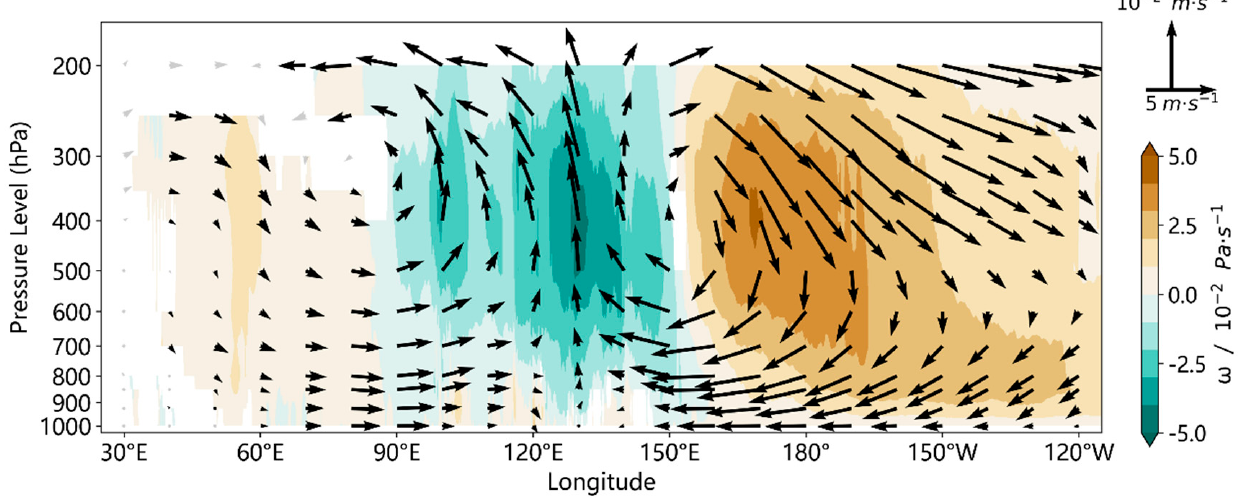
Figure 9. Vertical section differences (strong years minus weak years) of equatorial (average of 5 ◦ S–5 ◦ N) vertical velocity (shade) and latitudinal circulation (arrow) over the tropical Indo-Pacific Ocean during TC season (May to December) in anomalous SCSSM years. Shaded areas are statistically significant at the 90% confidence level.